Question: Describe this figure in one sentence.
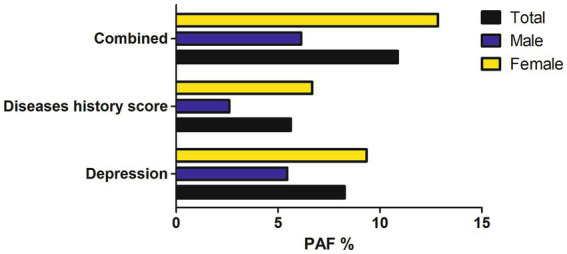
Answer: PAF of disease history score and depression history for current myalgic encephalomyelitis/chronic fatigue syndrome.